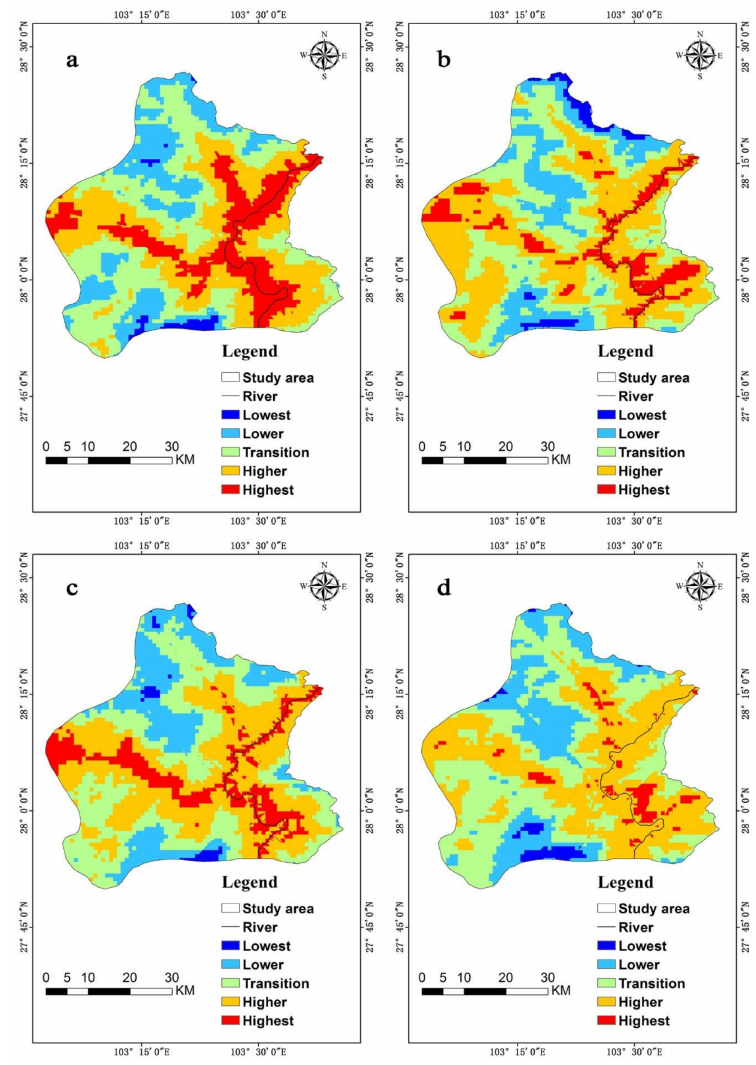
Figure 4. ( a ) Spatial distribution of NTD class before HSC in wet season; ( b ) spatial distribution of NTD class before HSC in dry season; ( c ) spatial distribution of NTD class after HSC in wet season; and ( d ) spatial distribution of NTD class after HSC in dry season. Table 5. Percentage (%) of TD-class per season and time respect hydropower station construction (HSC). Before HSC in Wet Before HSC in Dry Grade Season